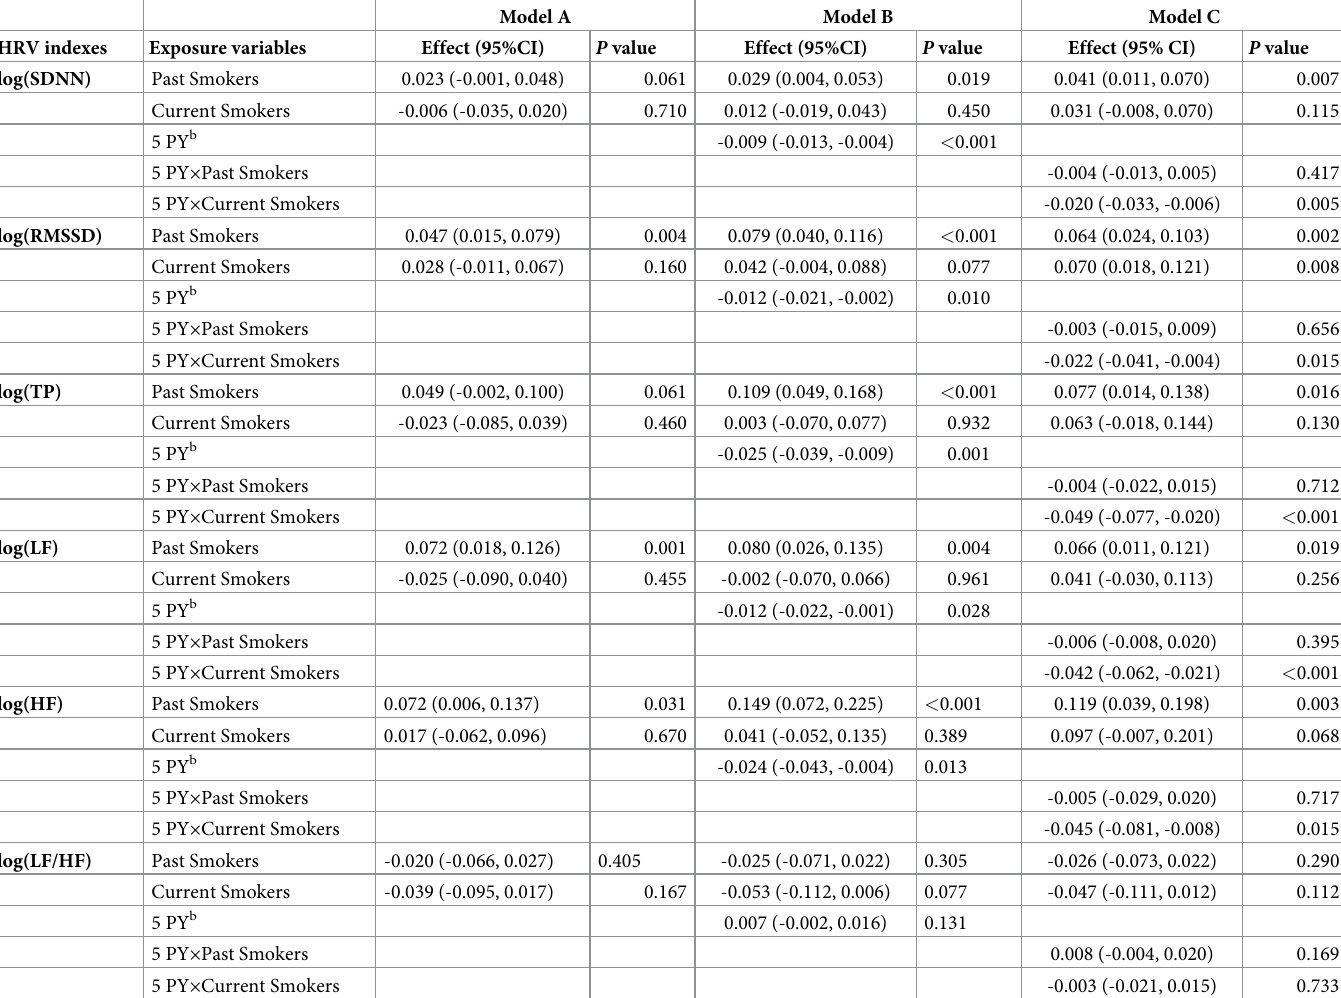
Table 3. Association of smoking status and pack-years with HRV a